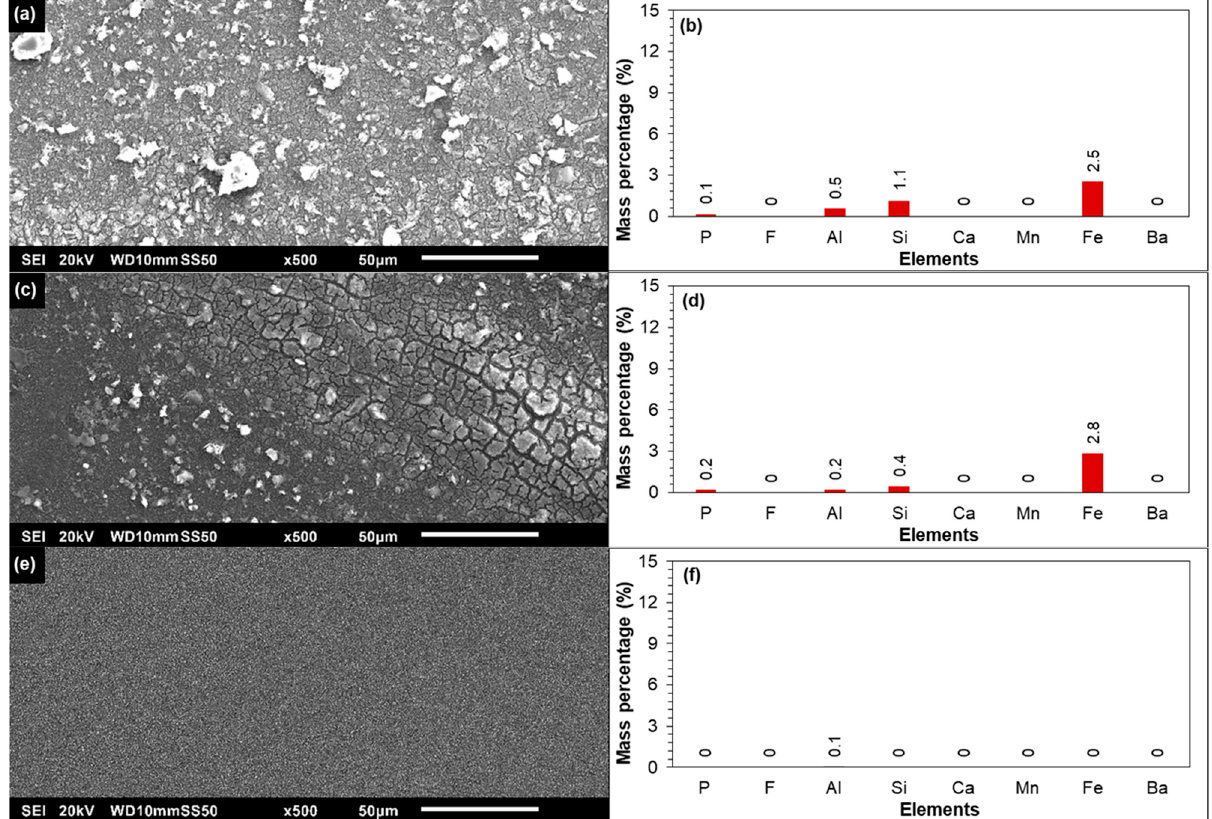
Figure 5. ( a ) SEM and ( b ) EDX analyses of the tail element of the first stage with decreased perme- ability. ( c ) SEM and ( d ) EDX analyses of the tail element of the first stage cleaned with a 0.05 M NaOH solution. ( e ) SEM and ( f ) EDX analyses of the tail element of the first stage cleaned with a 0.05 M HCl solution. HCl